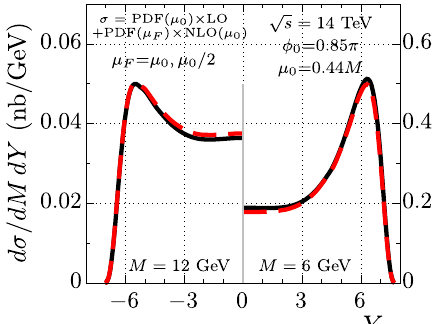
Fig. 5 Drell–Yan differential cross section given at two factorization scales μ F = μ 0 (black) and μ 0 / 2 (red). The azimuthal angle cutoff φ = 0 . 85 π isimposed,withoptimalscaleatLOgivenby μ 0